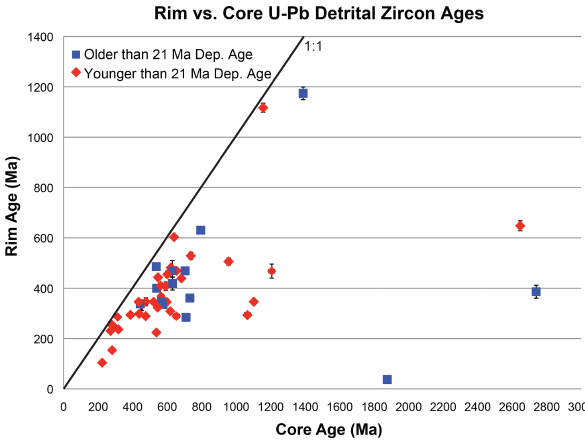
Figure 9. Rim vs. core ages for detrital zircon grains from samples with depositional ages older than 21Ma and younger than 21Ma from the Lucerne Section. Prior to the 21Ma transition in the source area, there is a minor number of Variscan rims on Cadomian and Caledonian cores. In samples younger than 21Ma there is a no- ticeable increase in Variscan rims on Caledonian, Cadomian, and Proterozoic cores. Error bars are 2 σ non-propagated